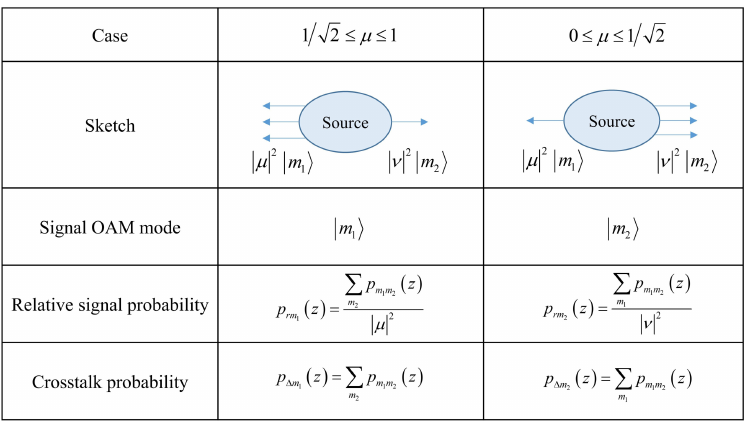
Figure A1. Plot detail of Figure